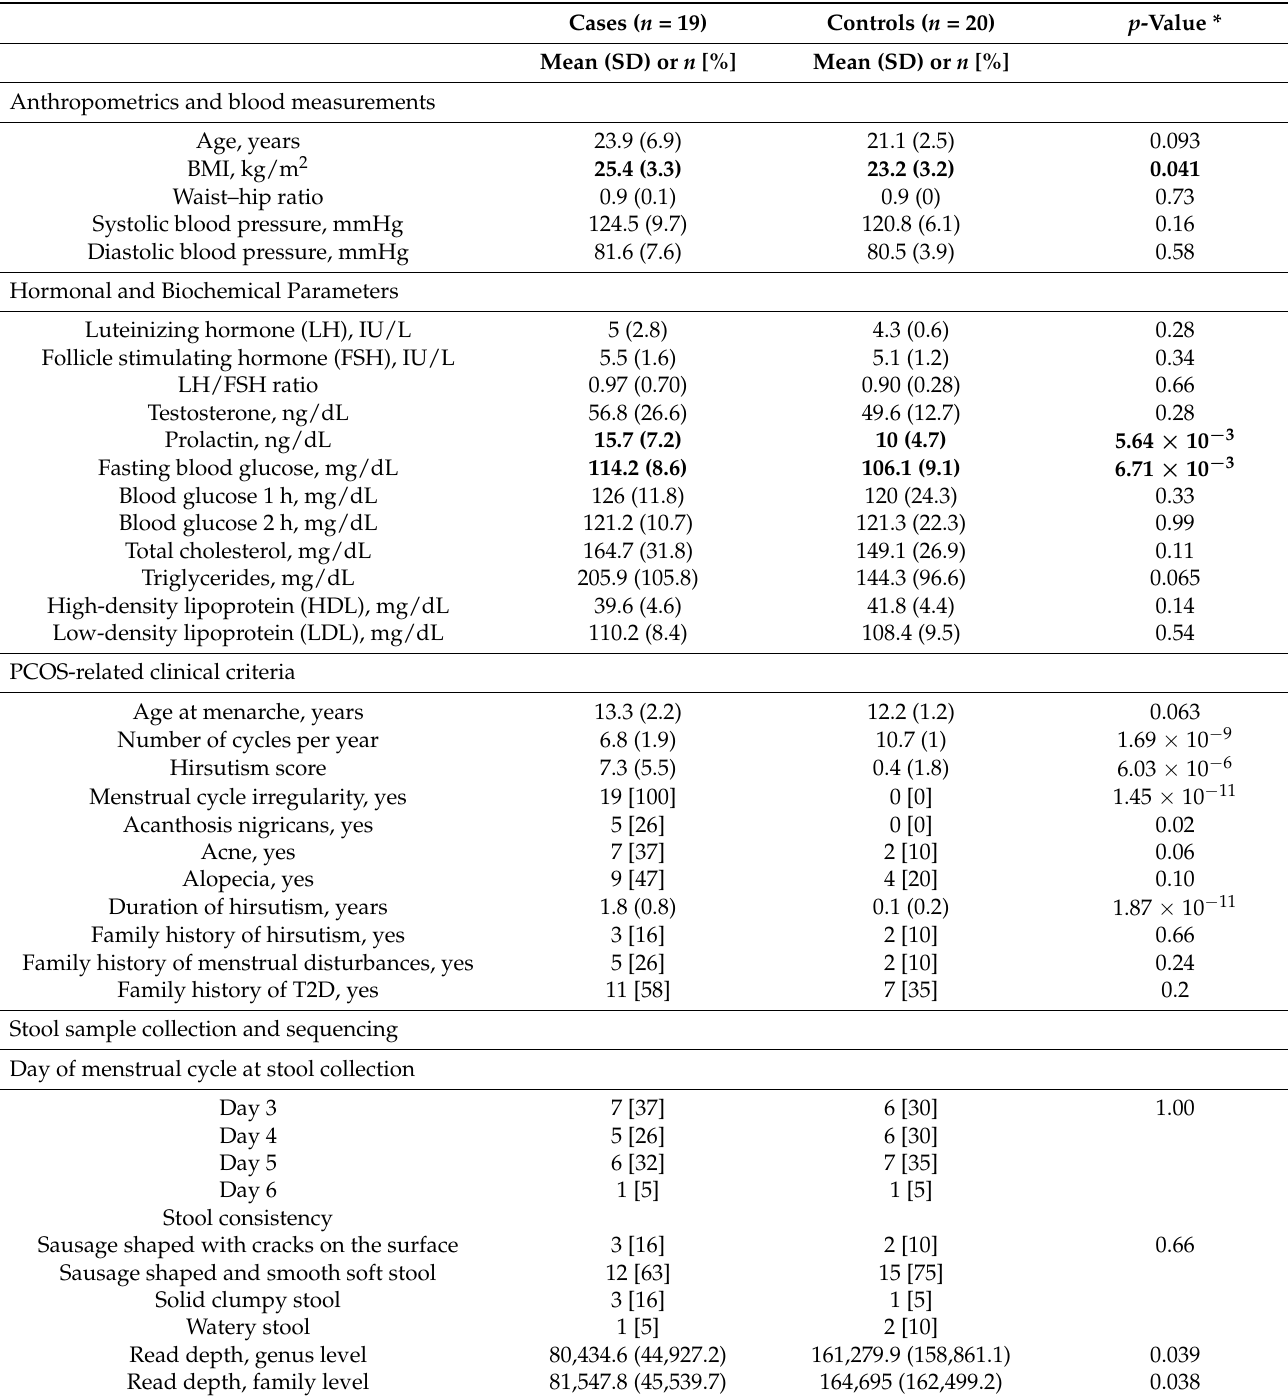
Table 1. Characteristics of the study